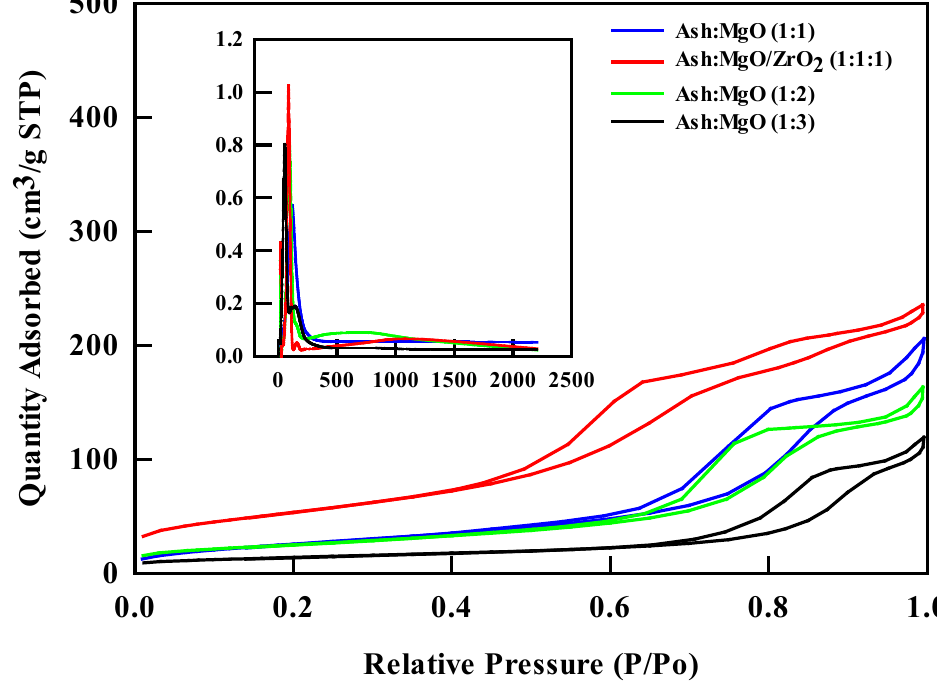
Figure 3. N 2 absorption and desorption, isothermal and pore size distribution plot (inserted) of Ash:MgO (1:1, 1:2, 1:3) and Ash:MgO/ZrO 2 (1:1:1) .